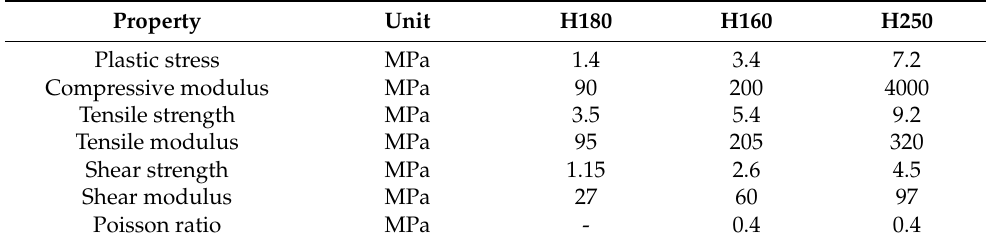
Table 1. Parameters of PVC foams